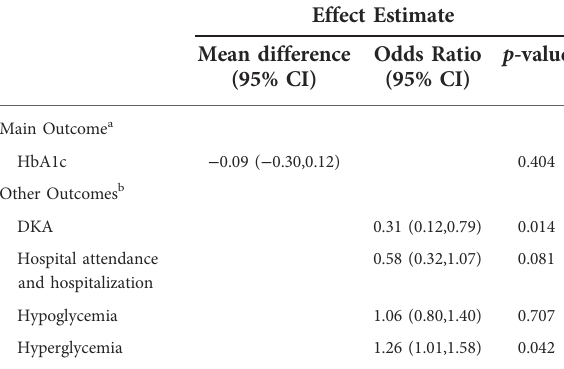
TABLE 4 Sensitivity analysis using multiple imputations and generalized estimating equation model to assess glycemic outcomes ( n